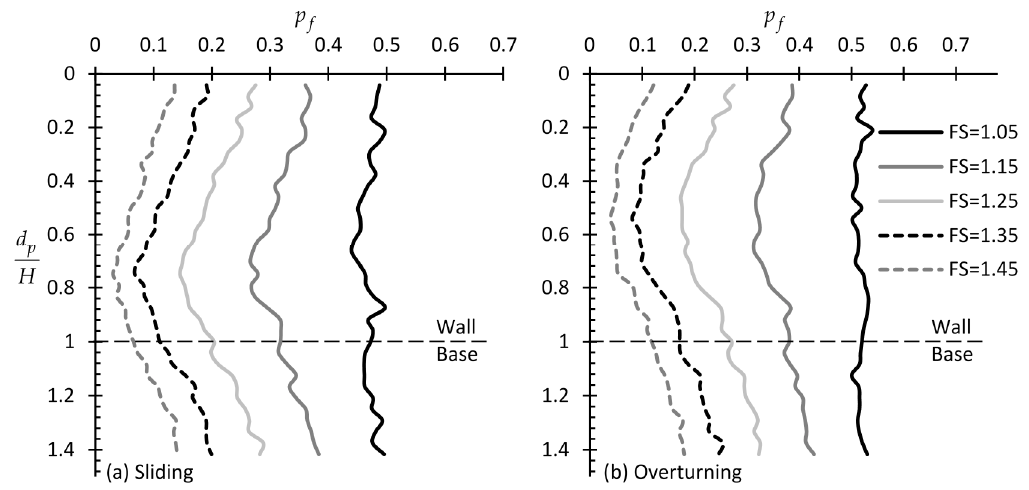
Figure 9. p f − d p / H curves for x / H = 0.5, θ / H = 2.08 and di ff erent factor of safety values for the ( a ) = Figure 9. f p - p d H curves for x H 0.5, H θ = 2.08 and different factor of safety values for the sliding and ( b ) overturning modes of ( a ) sliding and ( b ) overturning modes of failure.